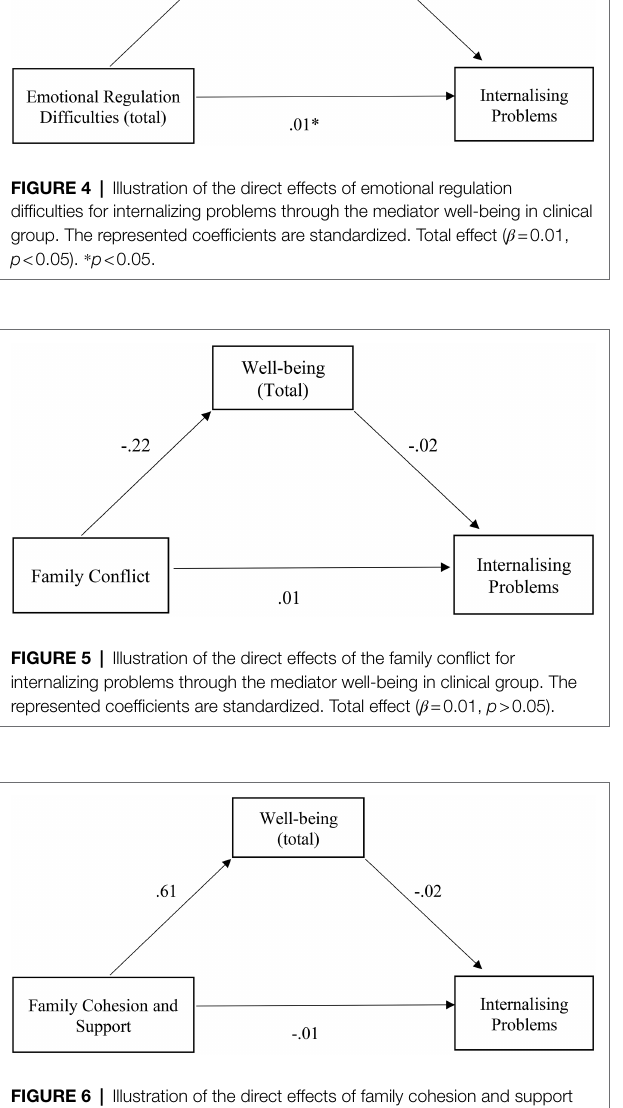
FIGURE 6 | Illustration of the direct effects of family cohesion and support for internalizing problems through the mediator well-being in clinical group. The represented coefficients are standardized. Total effect ( β = 0.02, p > 0.05).